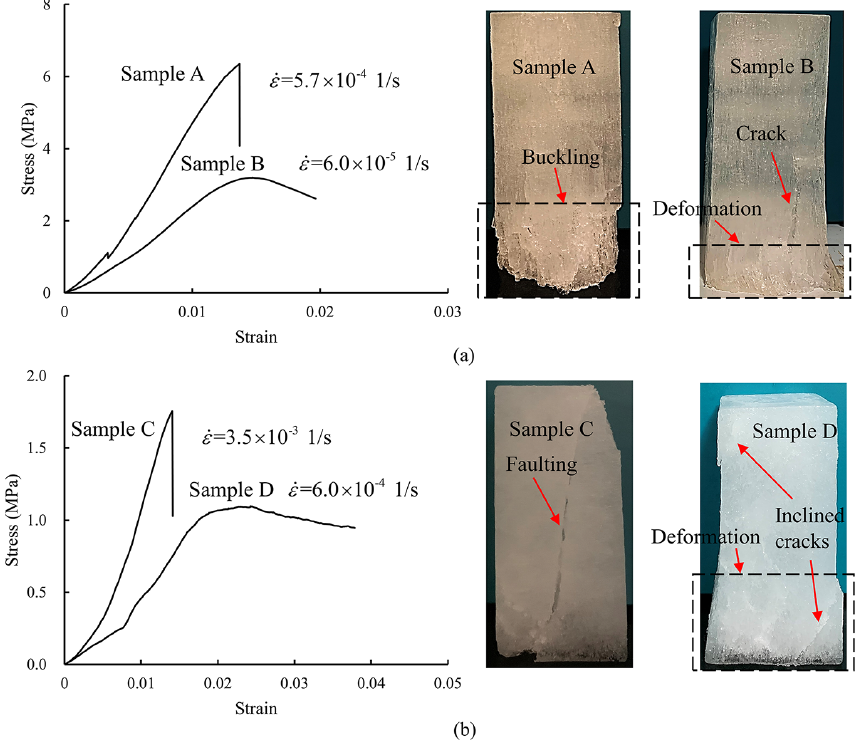
Figure 9. Typical stress–strain curves and failure modes of (a) vertically and (b) horizontally loaded samples.